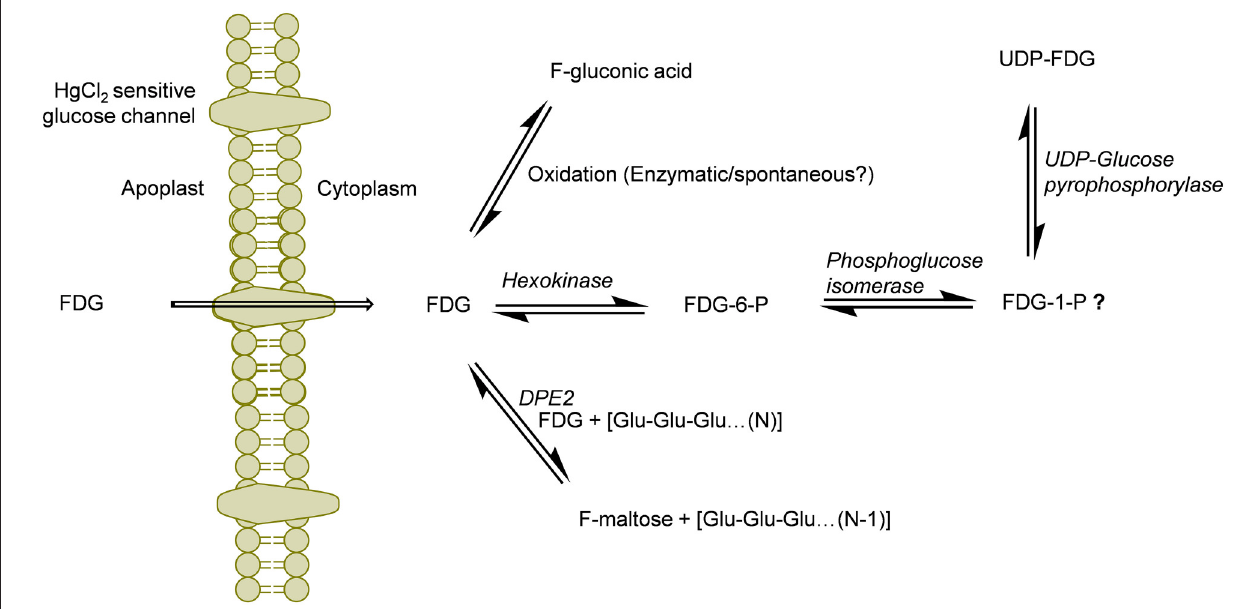
FIGURE 5 | Schematics of the potential routes of FDG metabolism in plant cell. FDG, 2-deoxy-2-fluoro- D -glucose; FDG-6-P, FDG-6-phosphate; FDG-1-P, FDG-1-phosphate; UDP, Uridine-diphosphate; F-maltose, 2-deoxy-2-fluoro-maltose; Glu, glucose; DPE2 , Arabidopsis disproportionating enzyme 2.